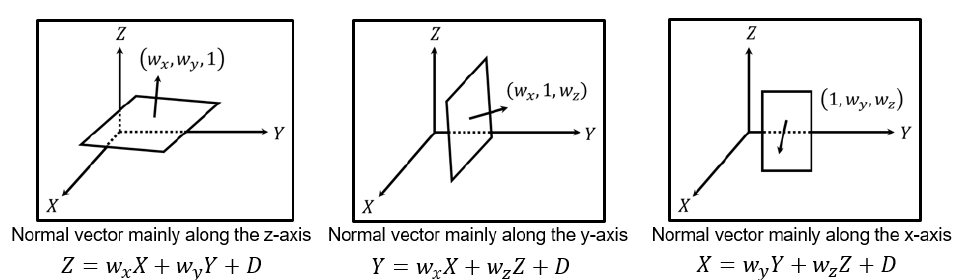
Figure 26. Three forms for representing a plane based on the orientation of the normal vector.